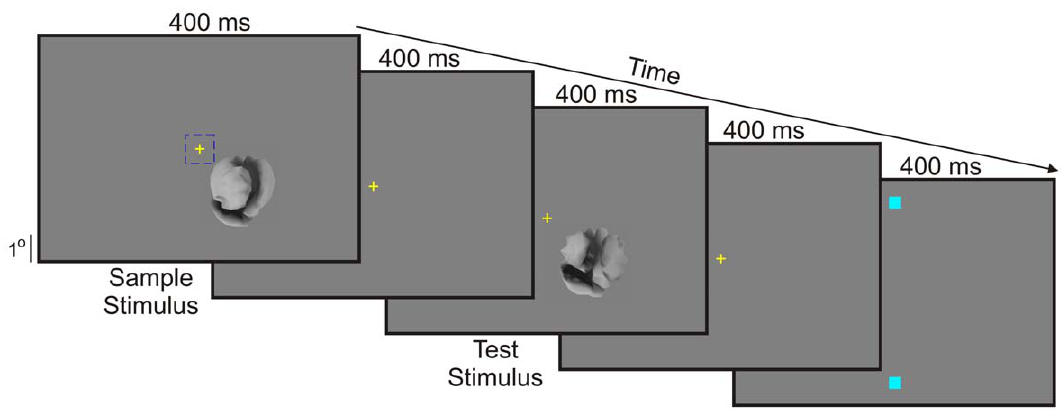
Figure 2. The trial paradigm. The animal performed a delayed same-different categorization task while maintaining fixation. After the animal established fixation on a central fixation target (‘ + ’) within an imaginary 6 0.5 u window (dashed square in far left frame), two eccentric stimuli were presented sequentially, each followed by a delay. After the second delay, the fixation target was turned off, at which time the animal indicated whether or not the two stimuli belonged to the same category by making a direct saccade to an appropriate saccade target (small blue squares in the far left frame). During the training phase of the study, both the stimuli during a given trial were whole objects. This figure shows a non-matching trial during training. Trials during the testing phase were identical (not shown), except that one of the stimuli during each trial was a fragment presented as a partial view of an object behind a light gray opaque occluder with a corresponding hole in it; the other stimulus in the trial was a whole object. In Experiments 1, 2 and 3, the fragment was presented as the first stimulus in each trial. See Materials and Methods for details. doi:10.1371/journal.pone.0015444.g002 categories. Figure 3 shows the category learning curve of the two animals for class X vs . class Y (see inset). Note that at the start of the training, either animal performed at chance levels, indicating